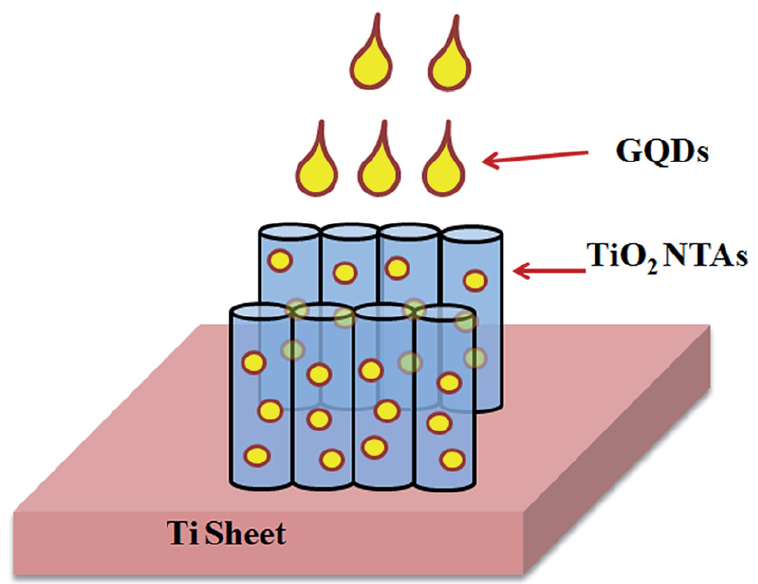
Figure 13. The systematic process of GQD-infilled TiO 2 NTAs. Reproduced from [93] with permis- sion from The Royal Society of Chemistry. from The Royal Society of